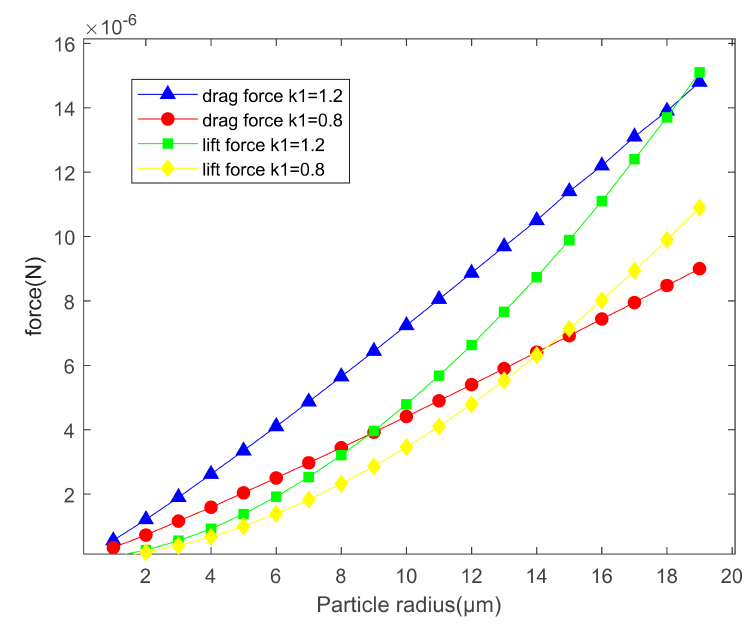
Figure 6. Changes in lift and drag under the influence of consistency coefficient.